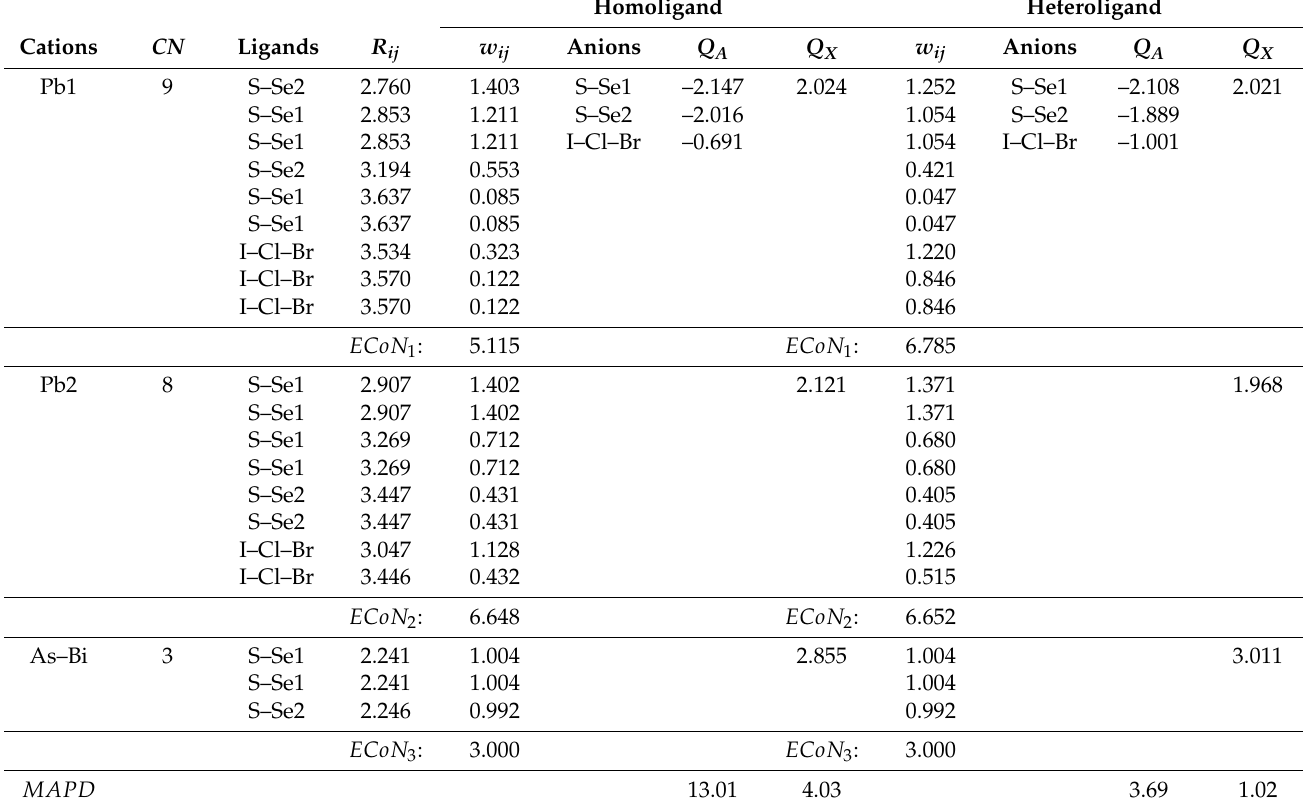
Table 2. Bond distances ( R ij ), bond weights ( w ij ) , ECoN X , calculated charges ( Q X , Q A ), and MAPD (%) for mutnovskite (Zelenski et al. [35]) in cation-centered, homoligand, and heteroligand